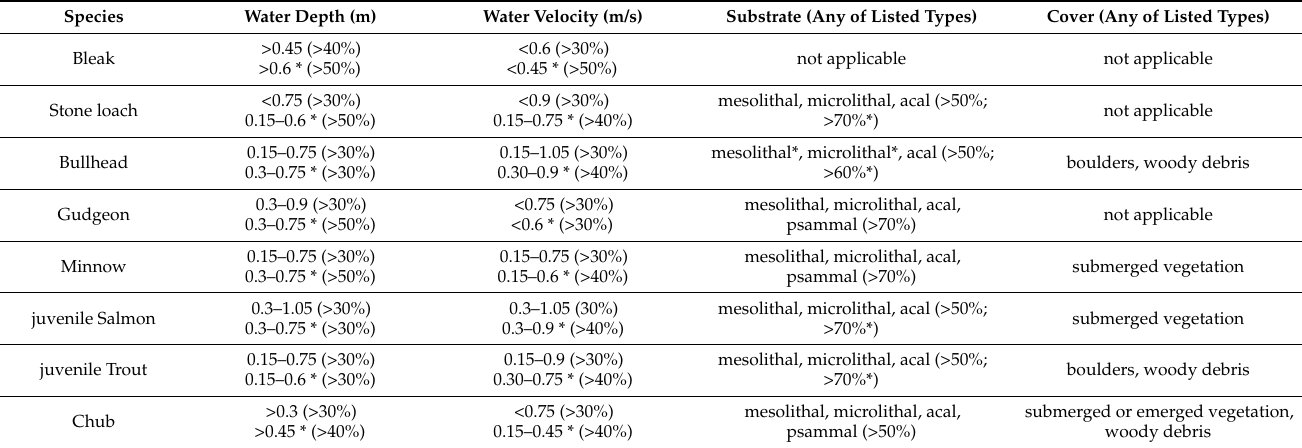
Table A1. Conditional habitat suitability criteria for fish species developed in this study. Star symbol (*) indicates abundance criteria. The percentage in parentheses indicates the minimum area of the HMU that must meet the